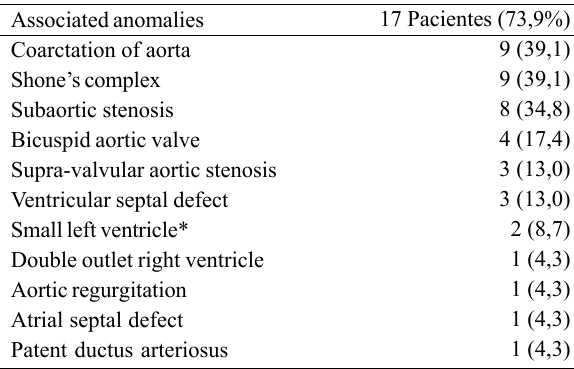
* the apex of the heart was not formed by the left ventricle